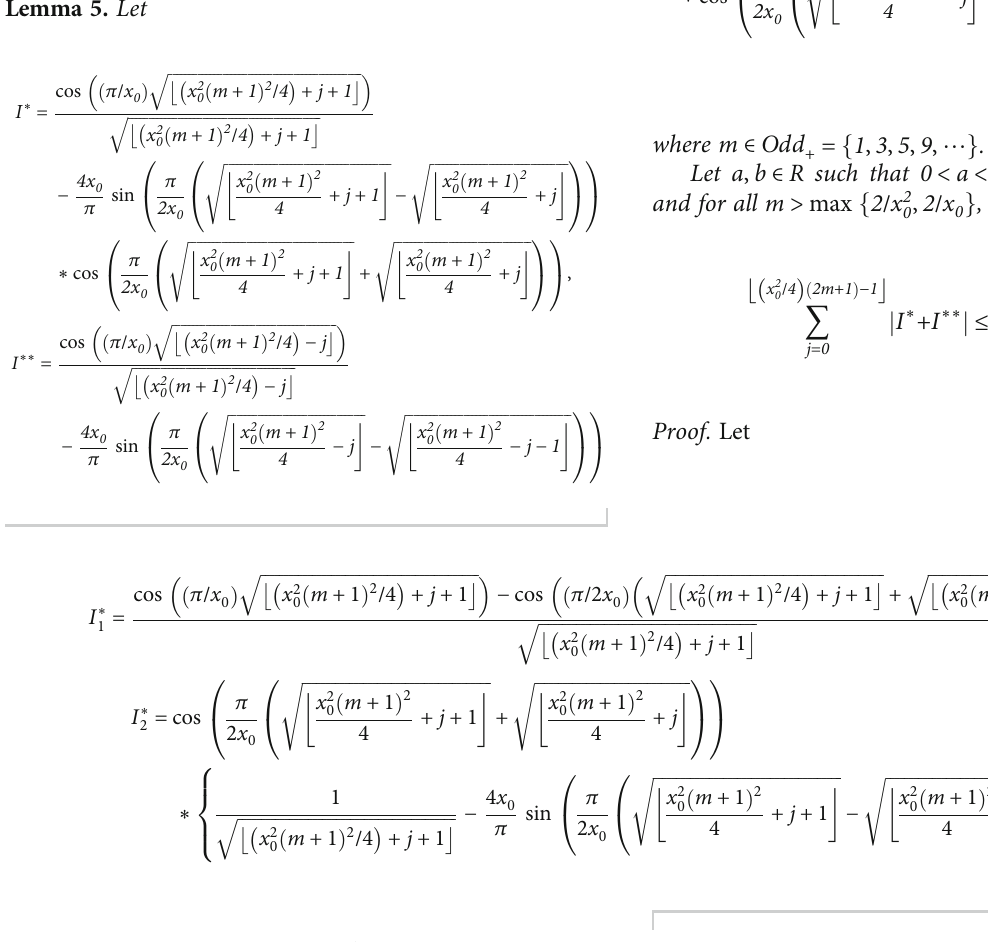
ffiffiffiffiffiffiffiffiffiffiffiffiffiffiffiffiffiffiffiffiffiffiffiffiffiffiffiffiffiffiffiffiffi x 2 m + 1 0